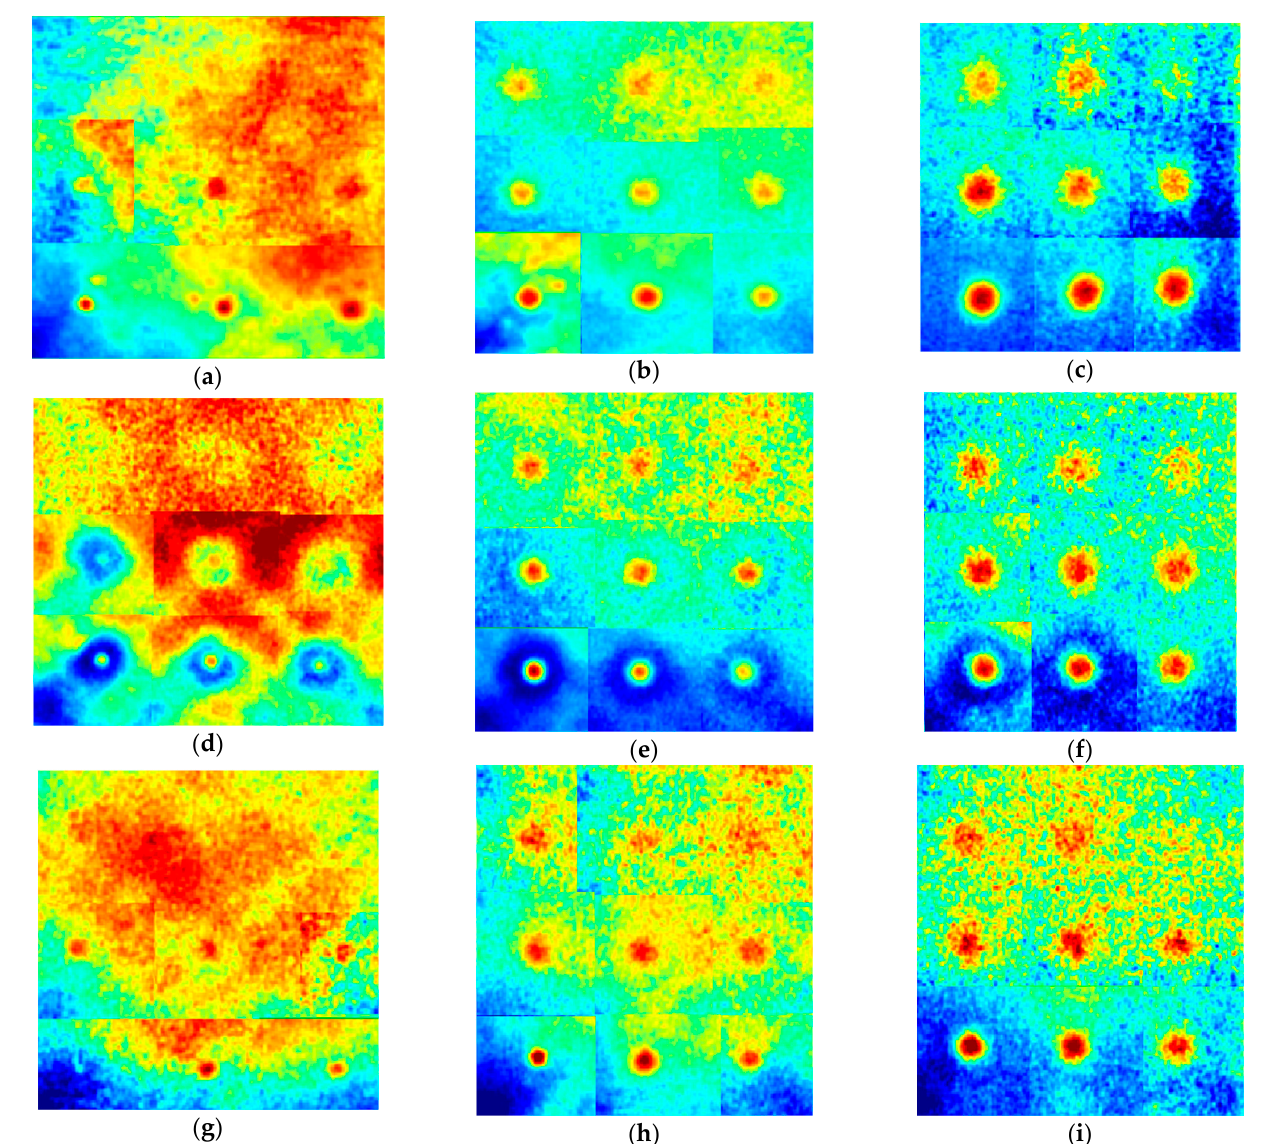
Figure 9. Synthetic IR thermograms of tested samples: ( a ) FBH, D = 1 mm, ( b ) FBH, D = 3 mm, ( c ) FBH, D = 5 mm, ( d ) disk, D = 1 mm, ( e ) disk, D = 3 mm, ( f ) disk, D = 5 mm, ( g ) sphere, D = 1 mm, ( h ) sphere, D = 3 mm, ( i ) sphere, D = 5 mm.